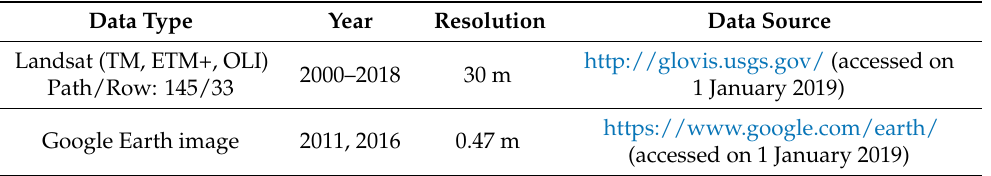
Table 1. Characteristics of remote-sensing data used in this